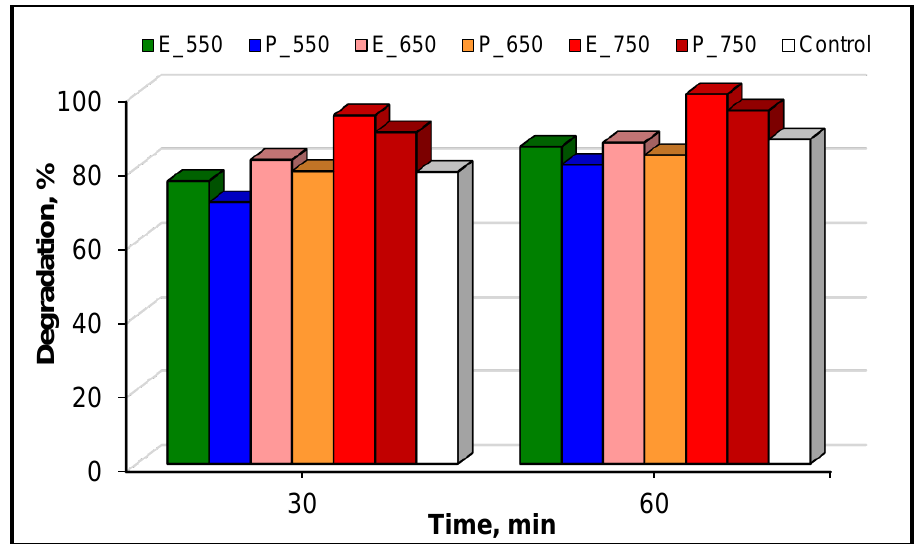
Figure 7. Photocatalytic activity of the TiO 2 samples prepared with ethanol (E series), isopropyl alcohol (P series) and a control sample (P25) for the degradation of clofibric acid under UV-A irradiation. CA = 10 mg·L −1 , catalyst = 0.5 g·L −1 and natural pH.